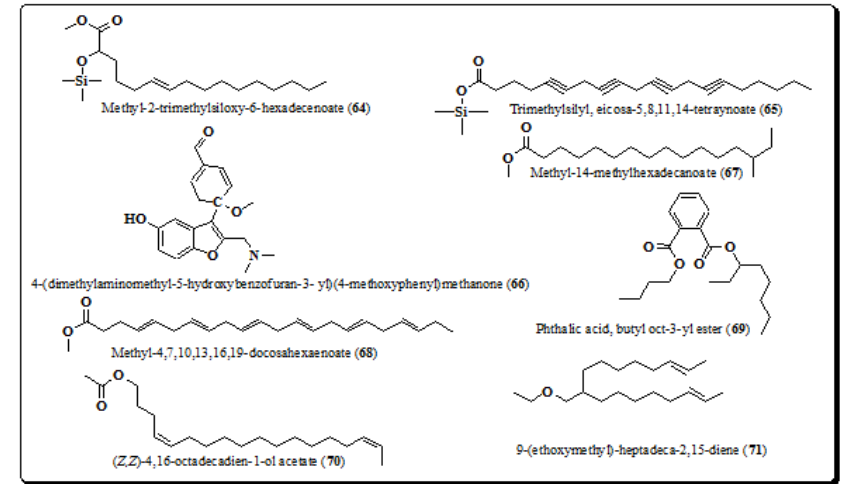
Figure 9. Structures of compounds from E. laevis ( 64 – 71 ).